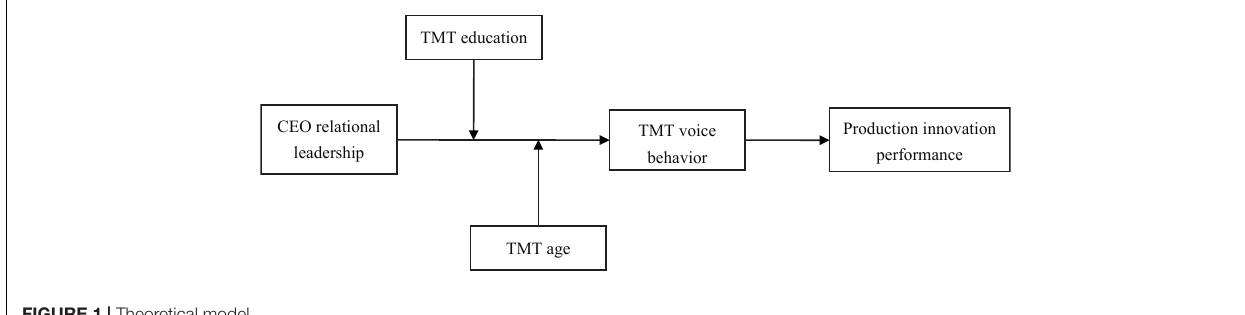
FIGURE 1 | Theoretical